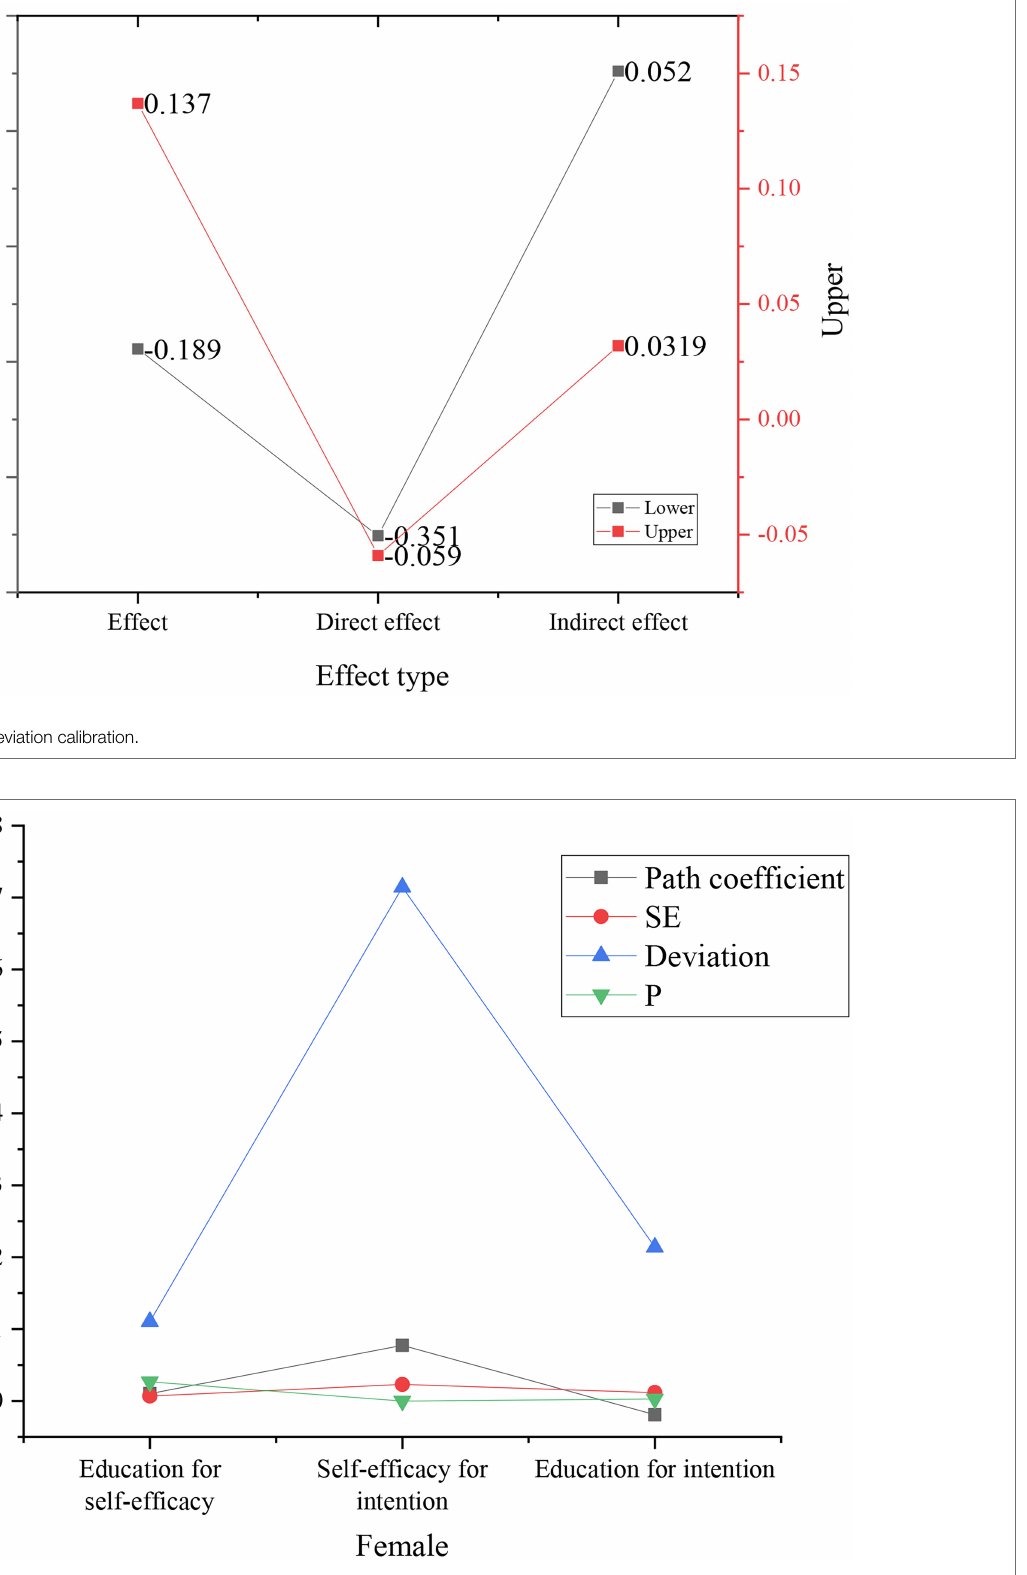
FIGURE 8 | Estimated results of the female